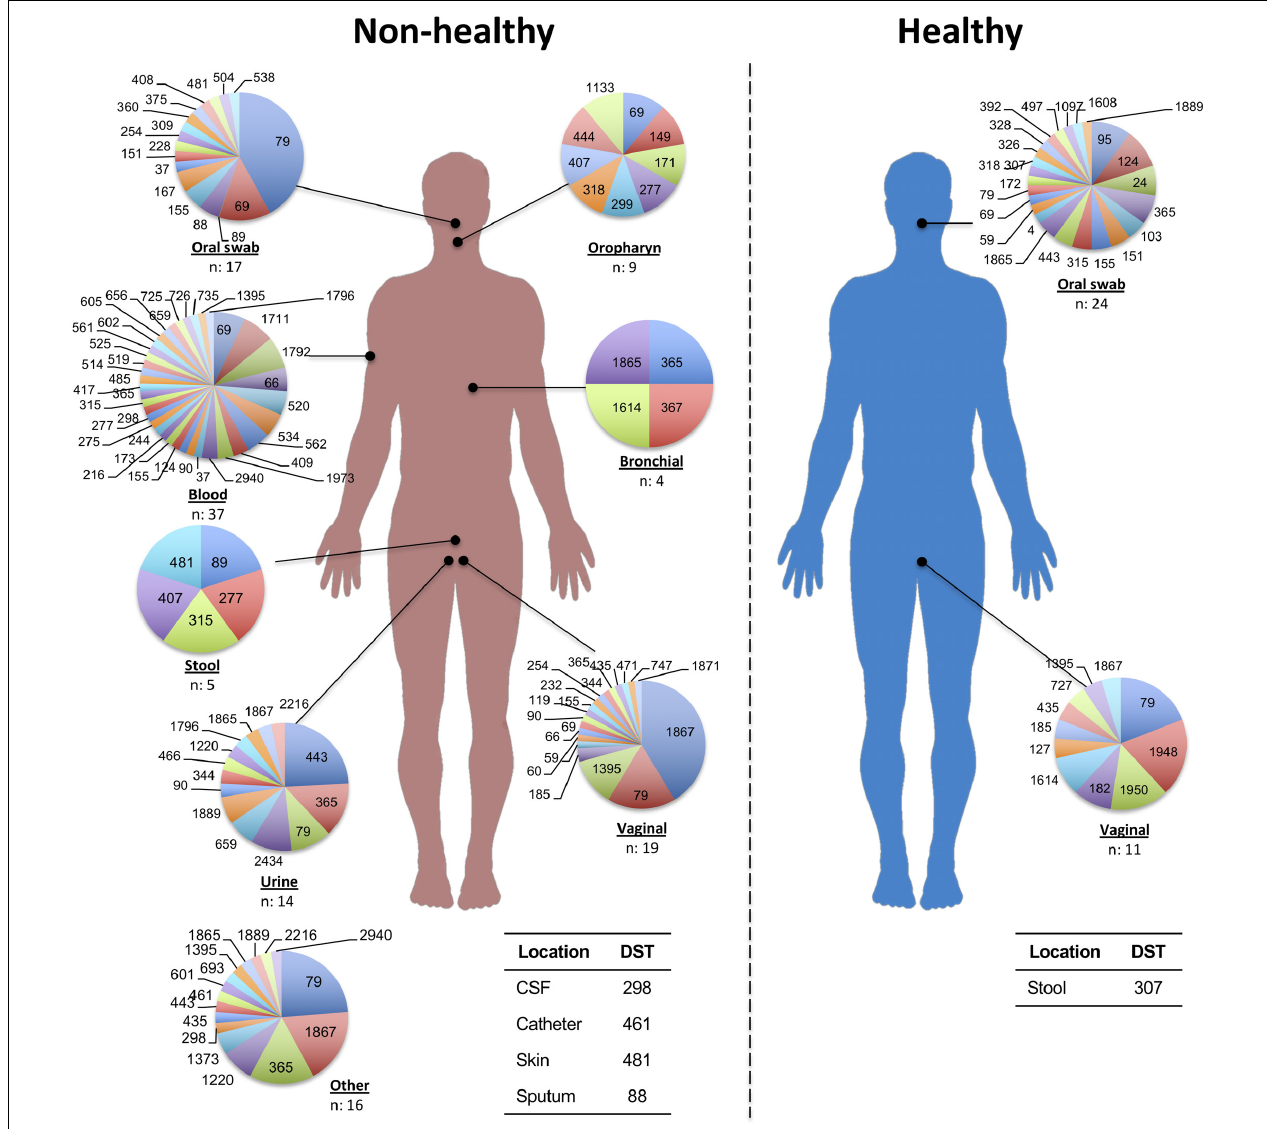
FIGURE 2 | DSTs reported by sample source with potential to be Healthy or Non-Healthy. Each circle represents the total number of isolations reported for the main sample sources (with the corresponding n -value shown in the lower part). Each DST frequency was calculated by considering the total number of DSTs per